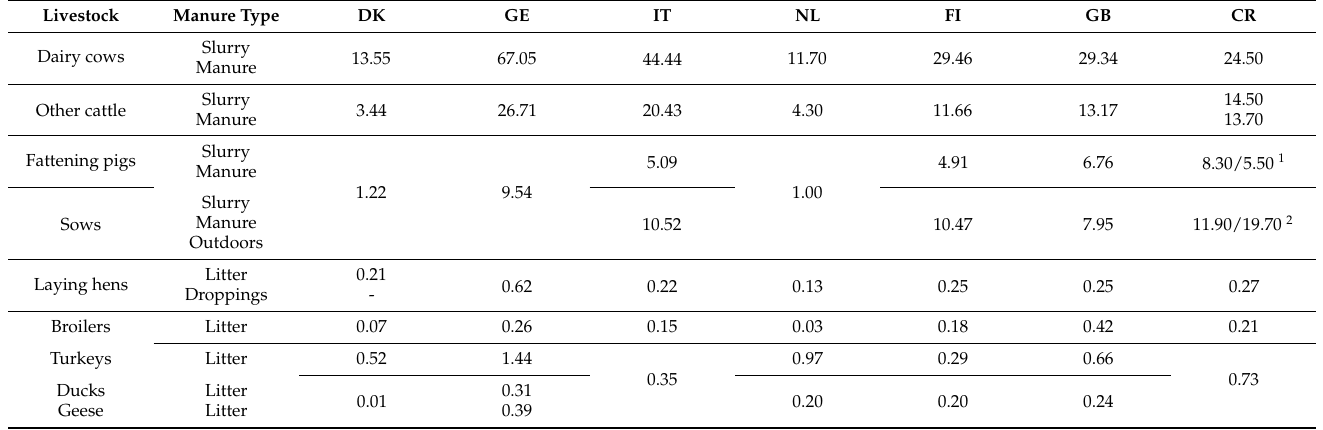
Table 1. For the construction of new installations or the extension of existing installations above the threshold, a simplified IPPC permit procedure must be carried out without